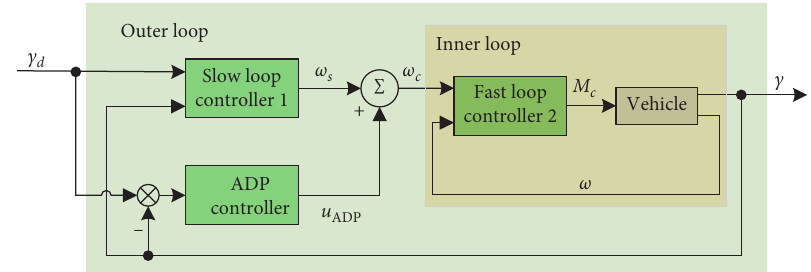
Figure 1: Dual-loop control structure based on